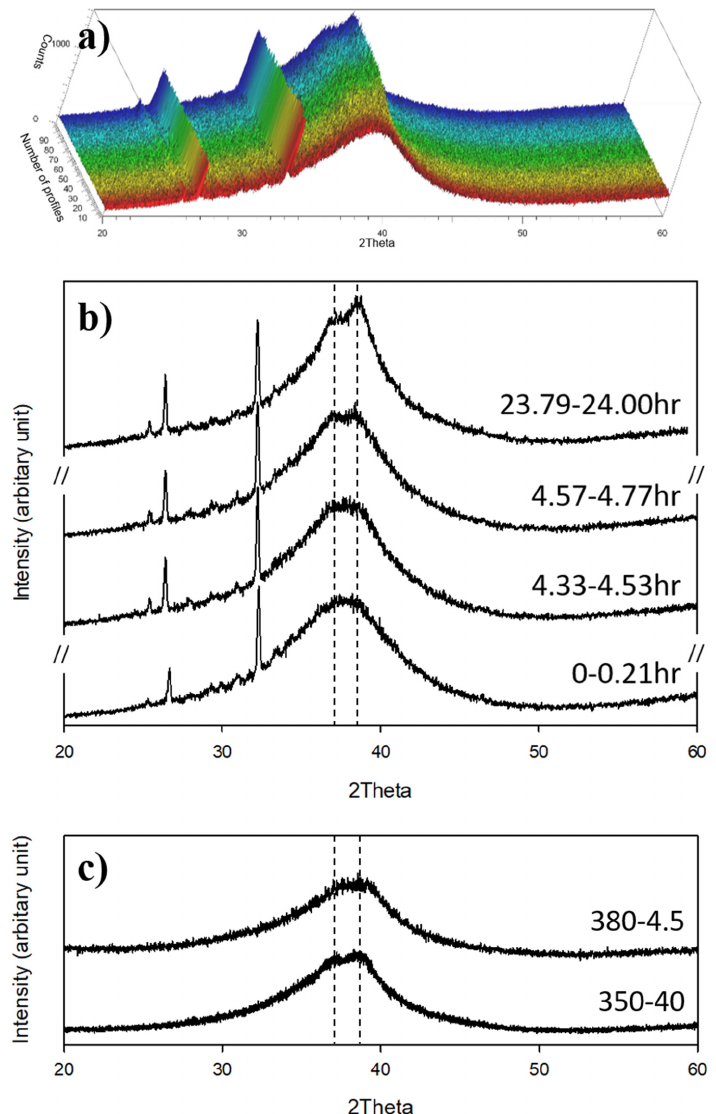
Figure 1. a ) In ‐ situ XRD profiles for thermal oxidation of Vit1b at 380° for 24 h taken every 20 min, b ) selected profiles (i.e., the 1st, 18th, 19th, and the 100th XRD profiles, from bottom to top) from in ‐ situ XRD analysis, c ) XRD profiles of Vit1b after CCT at 350 °C for 40 h (350 ‐ 40) and at 380 °C for 4.5 h (380 ‐ 4.5).